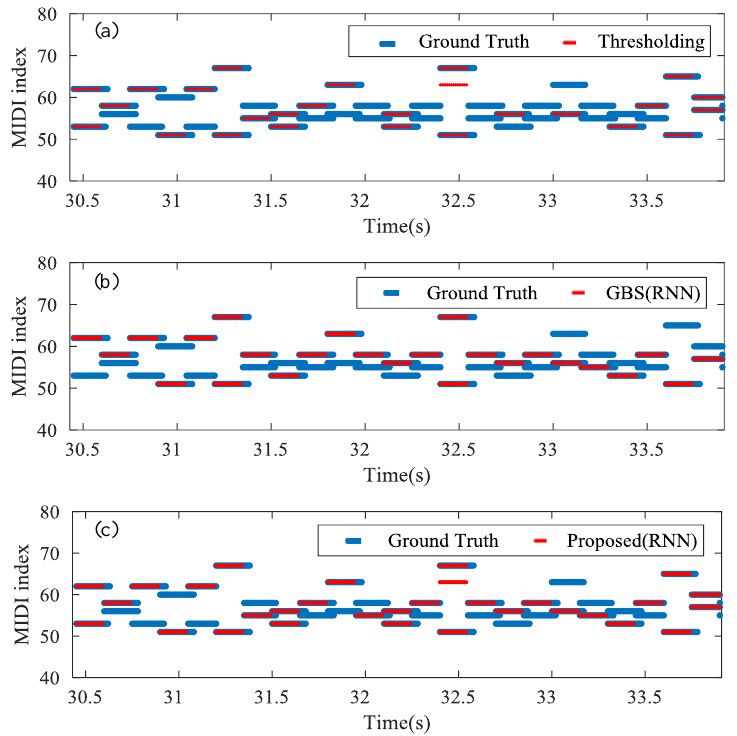
Figure 4. Binary piano-roll transcription of an example track obtained through the thresholding method ( a ), the GBS algorithm ( b ) and the proposed Local beam search (LBS) algorithm ( c